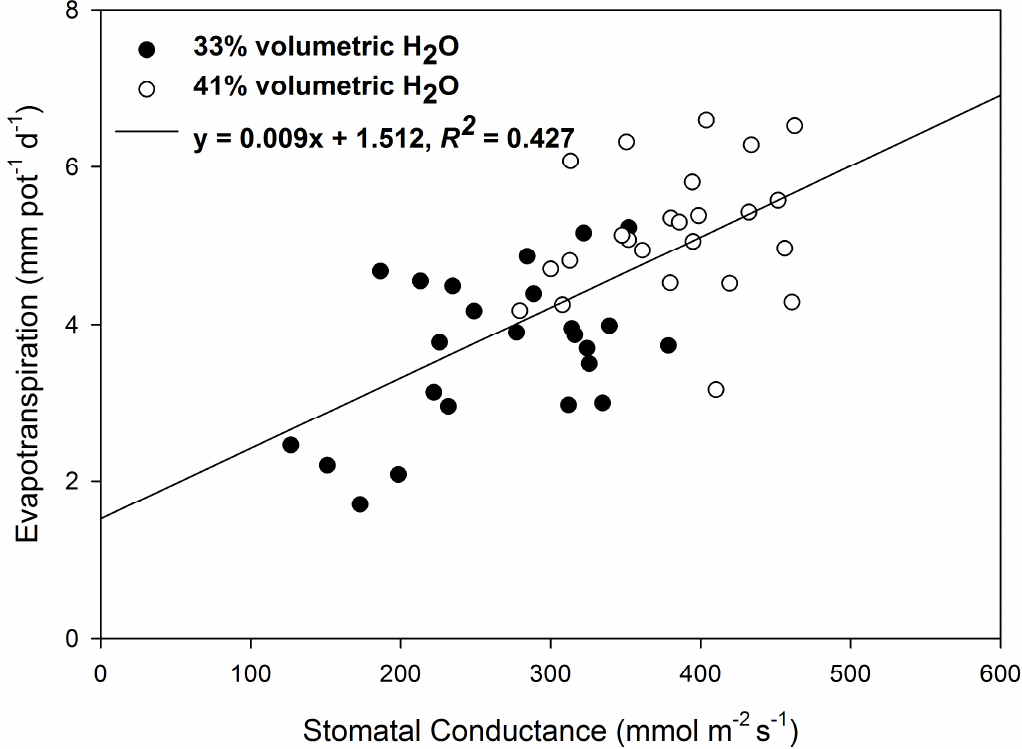
Figure 6. Faba bean average evapotranspiration rates and average stomatal conductance changes among water content treatments. The relationship between the evapotranspiration and stomatal conductance for both water contents is displayed. The high water content treatment (41% volumetric water content) exhibits the highest stomatal conductance and evapotranspiration, with the relatively lower water content (33% volumetric water content) showing the lowest stomatal conductance and evapotranspiration. One plant was grown per experimental